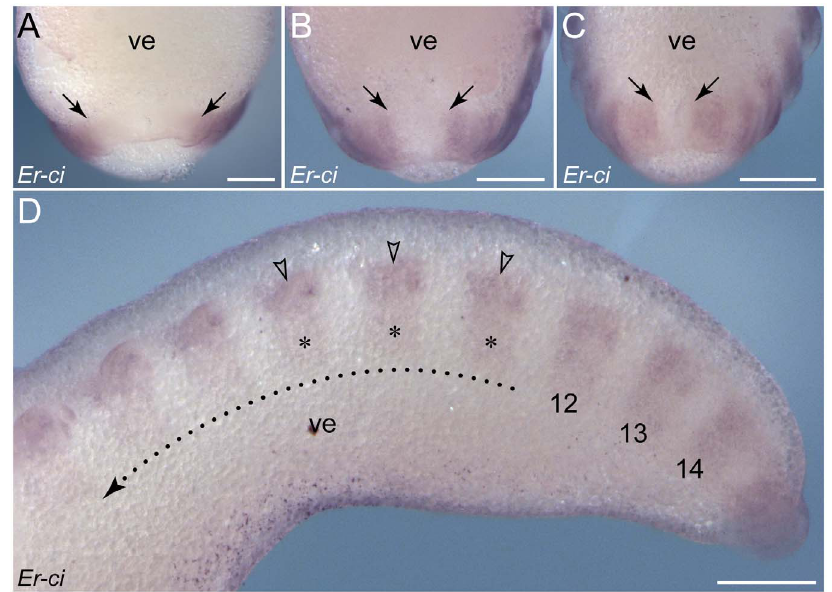
Figure 7. Details of cubitus interruptus expression in embryos of E. rowelli . (A–C) Posterior ends of embryos at developmental stages II, III and IV in ventral view. Arrows indicate the posterior-most regions of expression, which subsequently move towards the proctodaeum. (D) Posterior end of a stage IV embryo in lateral view. Leg-bearing segments and corresponding limbs are numbered. Dotted line with an arrow indicates the direction of decreasing expression in the ventral ectoderm (asterisks) but increasing expression in the limb anlagen (arrowheads) towards the anterior end. Abbreviation: ve , ventral extra-embryonic tissue. Scale bars: 250 m m